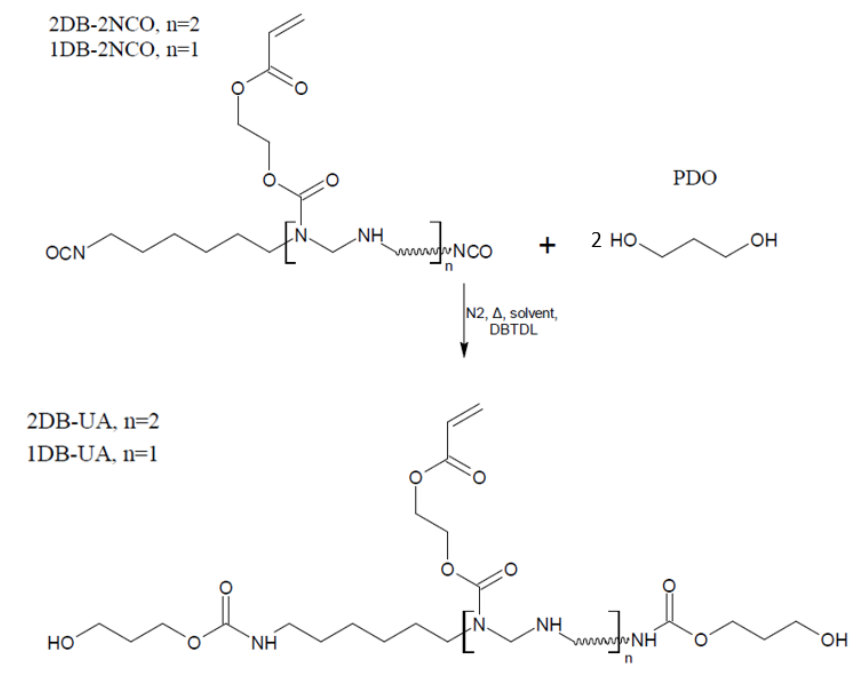
Figure 1. General structure of the obtained UA resins.